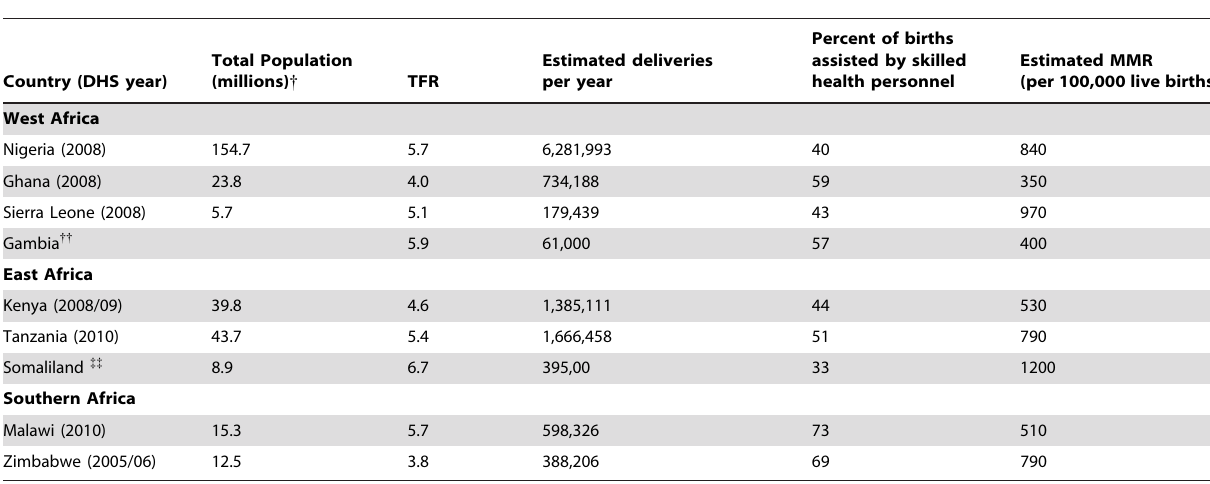
Table 3. Background maternal health indicators of nine participating